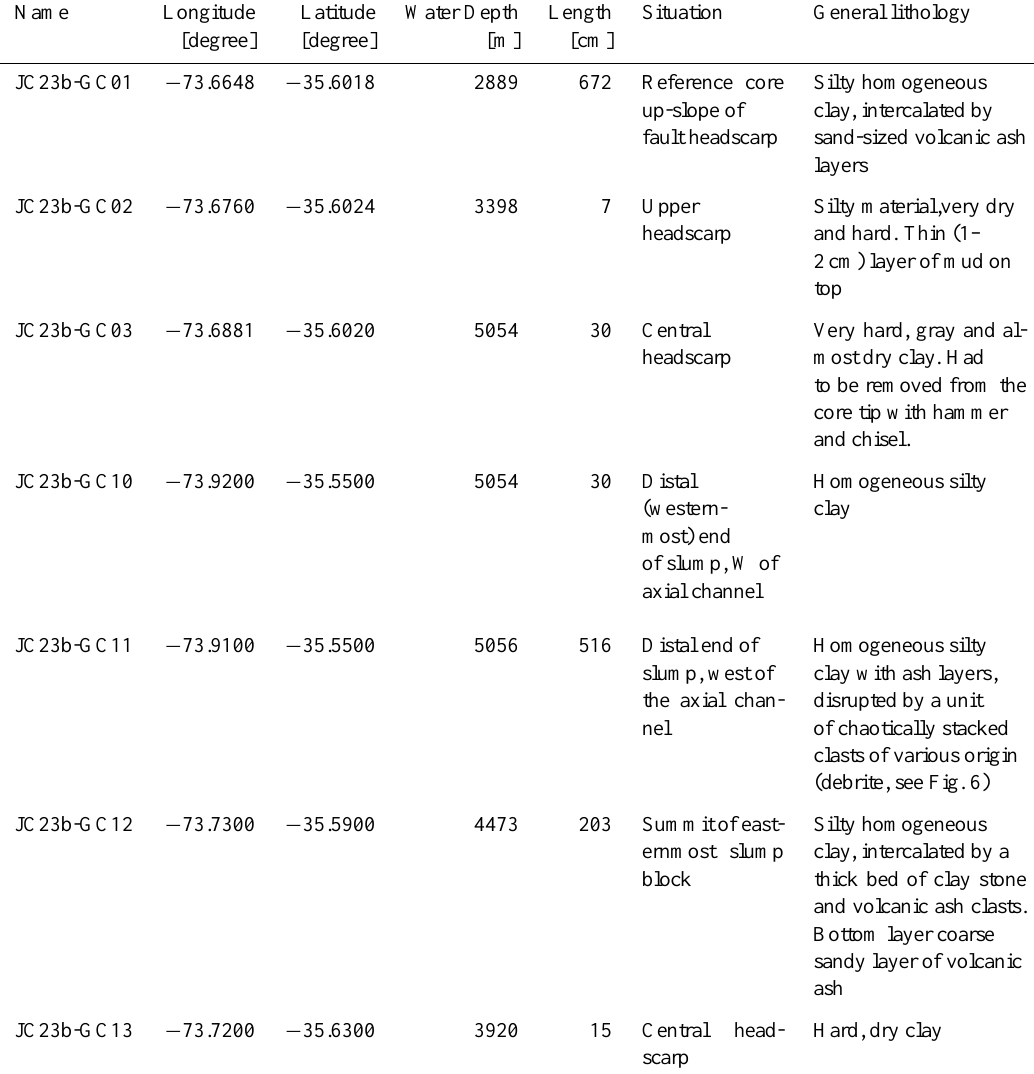
Table 4. Gravity core sites of RRS JAMES COOK cruise JC23b at the Reloca Slide